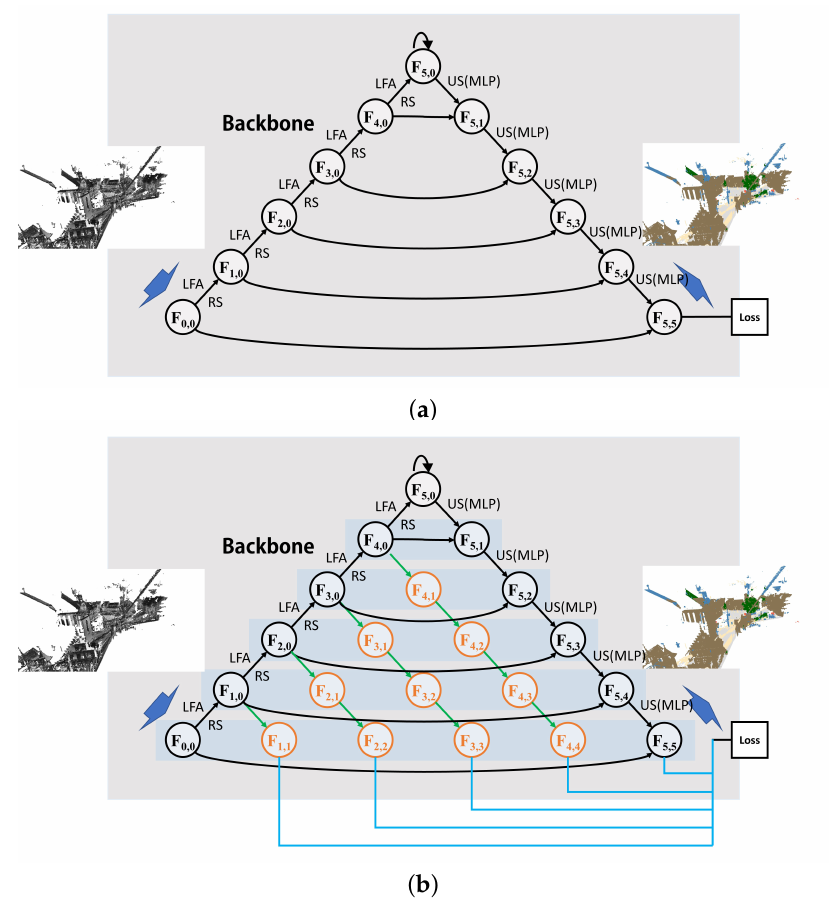
Figure 1. ( a ) RandLA-Net follows the standard encoder–decoder structures with skip connec- tions; this architecture is constructed by low-resolution with semantically strong features and high- resolution with semantically weak features. Where F i , j : the feature map after i encoding and j decoding (the initial values of i and j are both 0); LFA: Local feature aggregation, RS: Random sam- pling, US(MLP): Up-sampling by shared multi-layer perception. ( b ) Based on RandLA-Net, MFFRand concatenate multiple encoder-decoder structures with different depths. The same backbone is used for encoders of different levels of encoder–decoder structures. In the decoding stage, MFFRand starts decoding from different depths and performs feature fusion. The orange part indicates feature fusion, and the blue lines indicate that the training process is supervised by